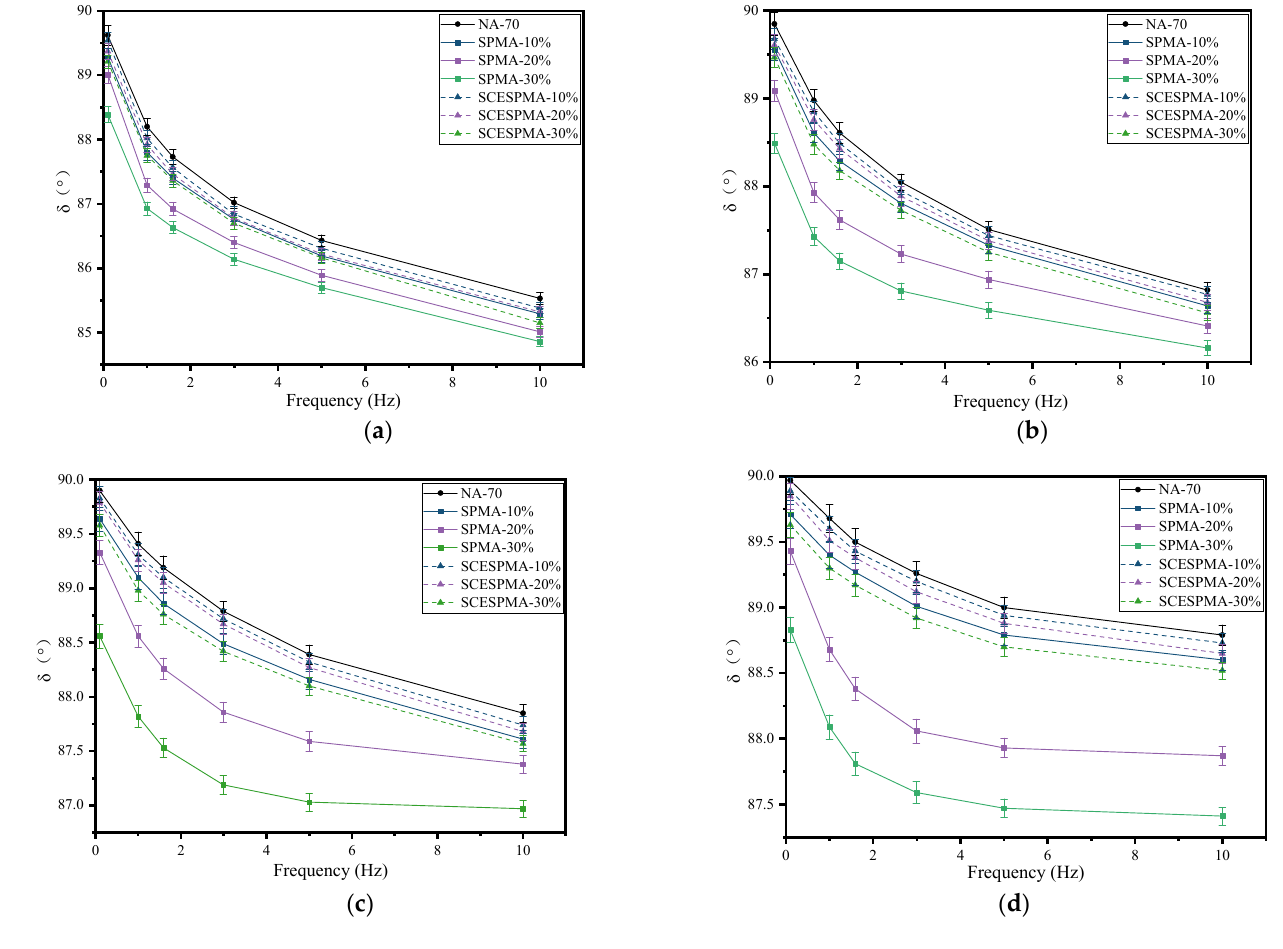
Figure 10. Relationship among δ and frequency of SPMA and SCESPMA at different temperatures. ( a ) 58 °C; ( b ) 64 °C; ( c ) 70 °C; ( d ) 76 °C.